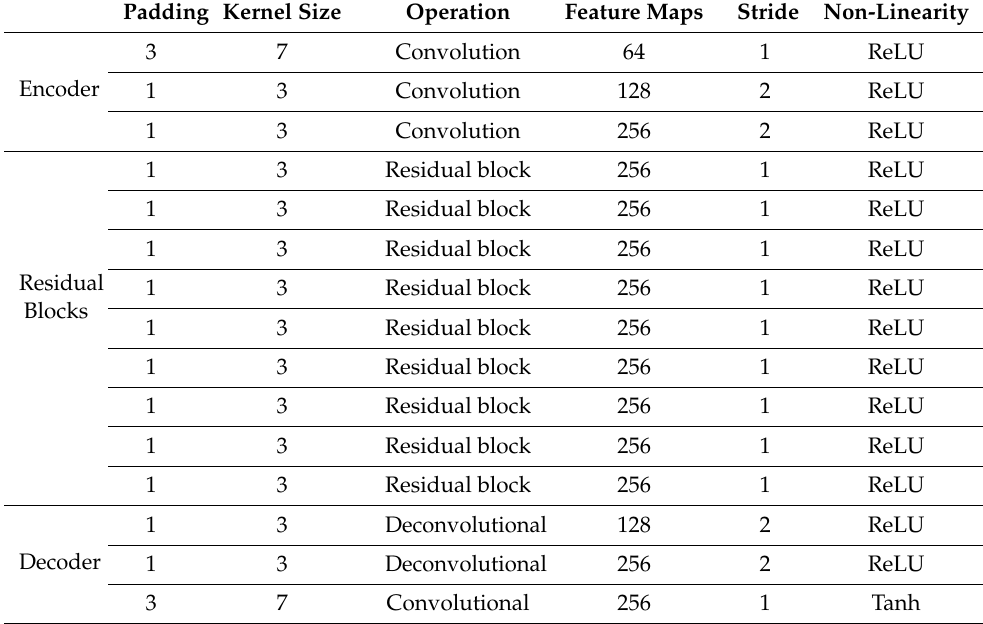
Table 2. Denoiser network of AGDN.